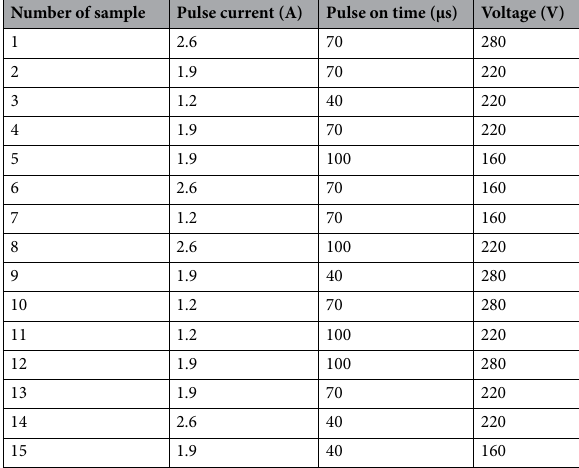
Table 1. Machining parameters used in the experiment and cutting